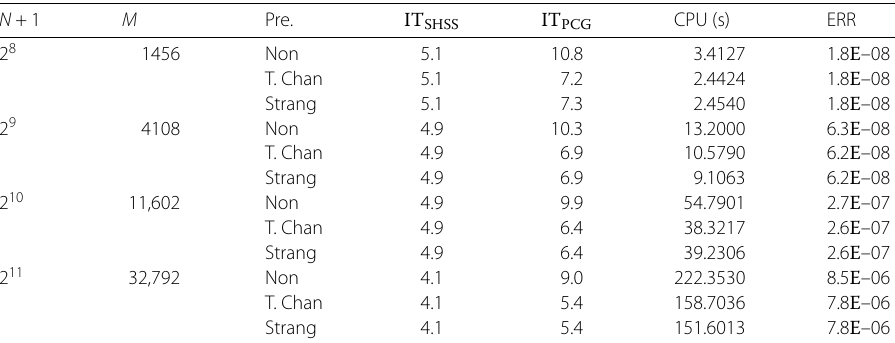
Table 2 Numerical results of the SHSS-PCG method for solving FDE ( α = 1.5) N + 1 M Pre. IT SHSS IT PCG CPU (s) ERR 2 8